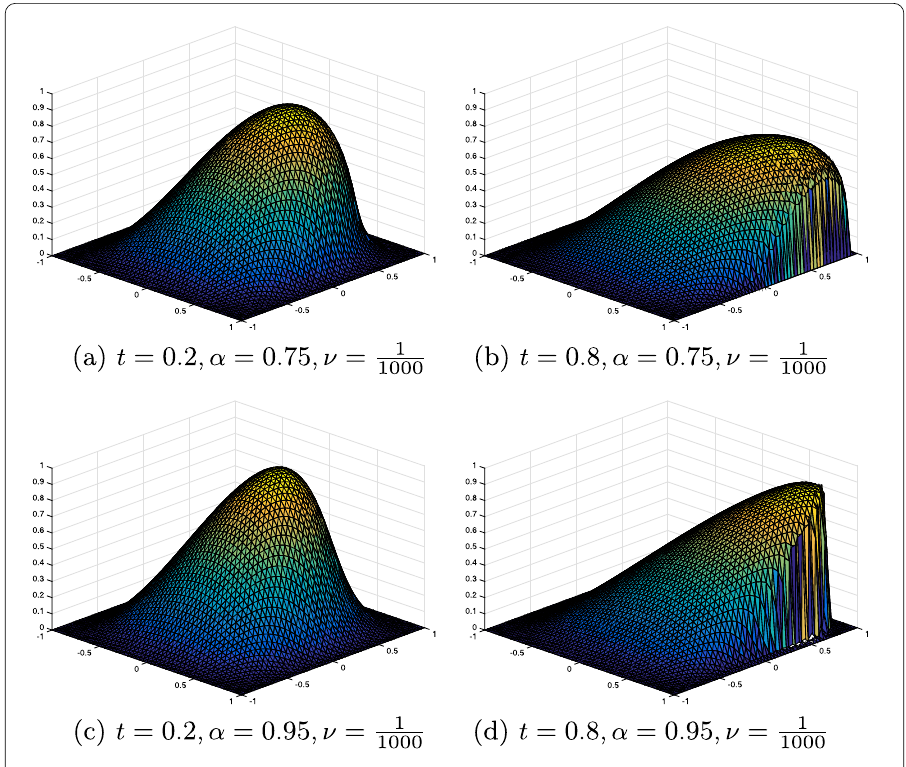
Figure 1 Solution of example 2 with different fractional orders and highReynoldsnumber (Re = 1,000) and at different